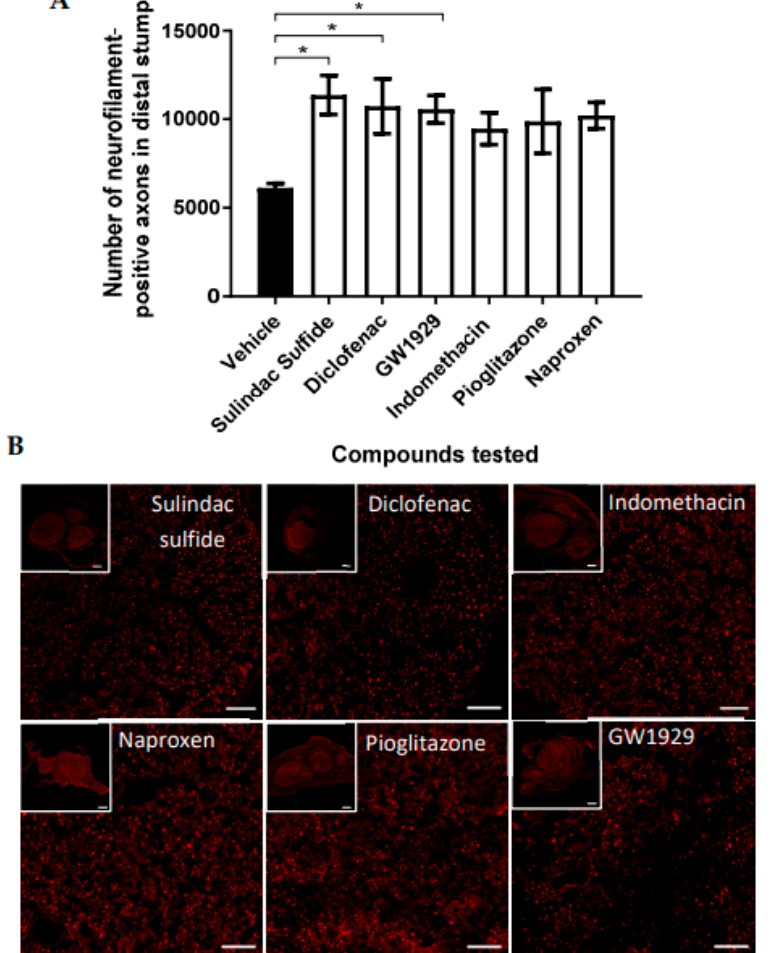
Figure 2. ( A ) The number of neurofilament-positive axons in the distal stump appeared to be elevated with all PPAR γ agonists in comparison with the vehicle control, with statistical significance seen with sulindac sulfide, diclofenac, and GW1929 local treatment. Doses delivered locally to the site of injury were 11 µg/day diclofenac, 11 µg/day sulindac sulfide, 2 µg/day GW1929, 12 µg/day indomethacin, 0.12 µg/day pioglitazone, and 8 µg/day naproxen. ( B ) Micrographs are transverse sections showing neurofilament-positive neurites at 5 mm distal to the injury site. Scale bar = 100 µm. N = 6, means ± SEM. One-way ANOVA with Dunnett’s post hoc test, * p < 0.05.